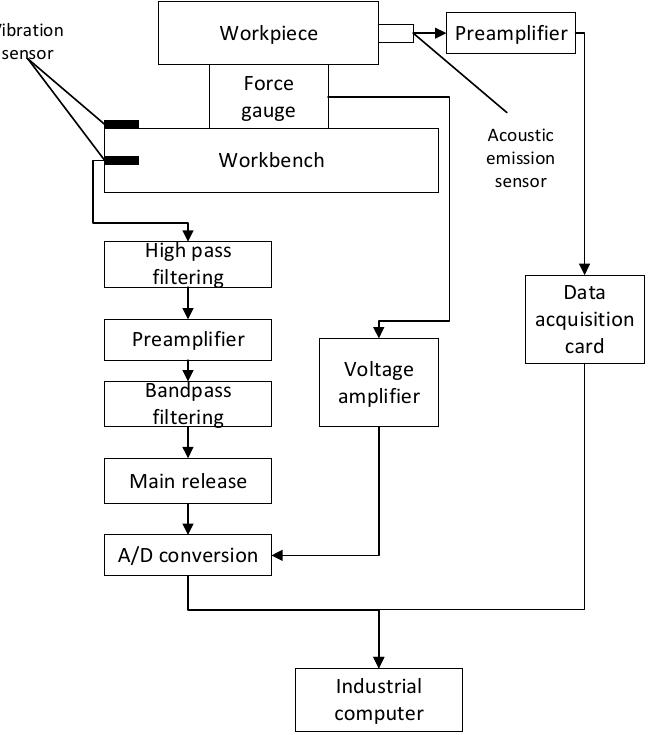
Figure 2. Signal acquisition principle.